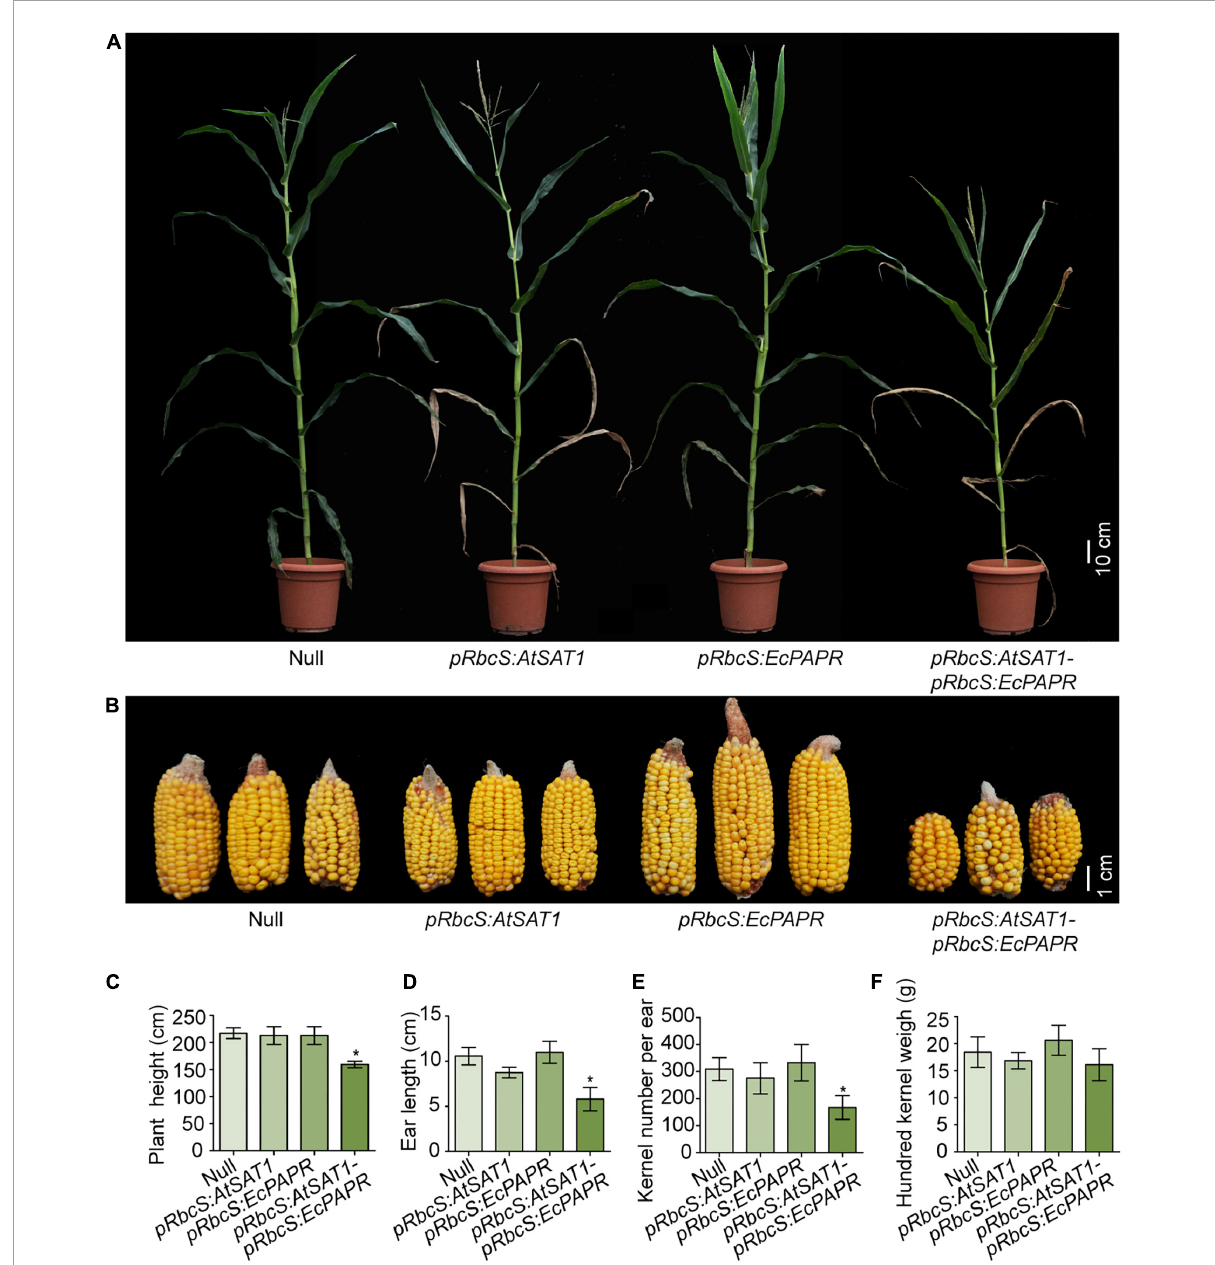
FIGURE1 Perform‘ance of transgenic lines under field conditions. (A) Representative photo of flowering plants for each type as labeled in the photograph. (B) Representative photos of ears for each type as labeled in the photograph. (C–F) Comparison of plant height (C) , ear length (D) , kernel per ear (E) , hundred kernel weight (F) between Null, pRbcS:AtSAT1 , pRbcS:EcPAPR , and pRbcS:AtSAT1-pRbcS:EcPAPR . The data shown are the means from 15 individual plants ± SD. Asterisks indicate significant differences from Null (Student’s t- test, * p -value < 0.05).